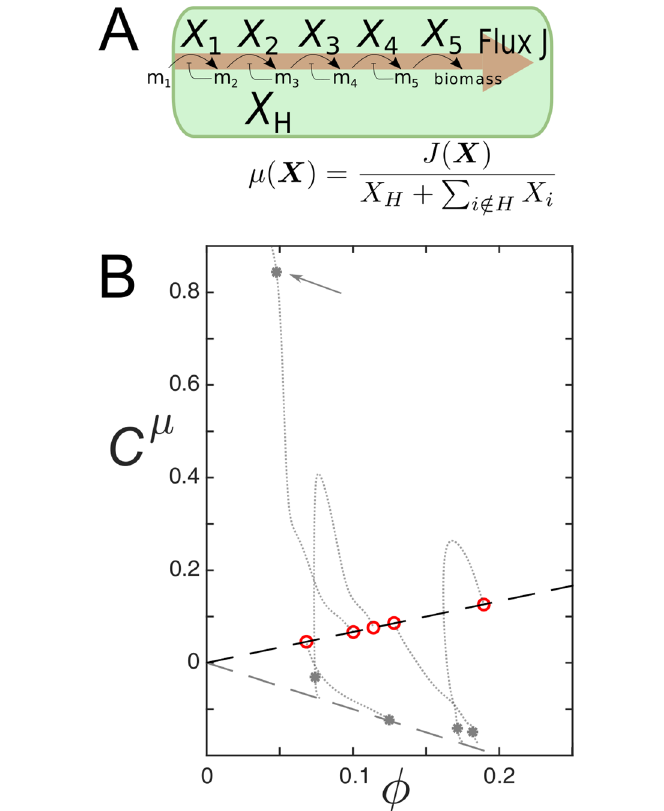
Fig 2. (A) Representation of the stochastic toy model. A cell expresses five metabolic protein species, each catalysing a single reaction in a linear reaction chain that imports and converts a fixed external metabolite, m 1 , into biomass. The growth rate is defined as the steady state flux through the network, divided by the total number of expressed proteins, including the H -sector protein. (B) Example trajectory of the GCCs of metabolic proteins during the optimisation of a single kinotype (grey dotted lines). Grey dots are GCCs at an early stage of this process and the arrow indicates the rate-limiting protein species. Red point are the values of the GCCs in the optimal genotype, matching the predicted scaling for metabolic proteins (positive dashed line, negative dashed line is the prediction for H -proteins). See S1 Table for